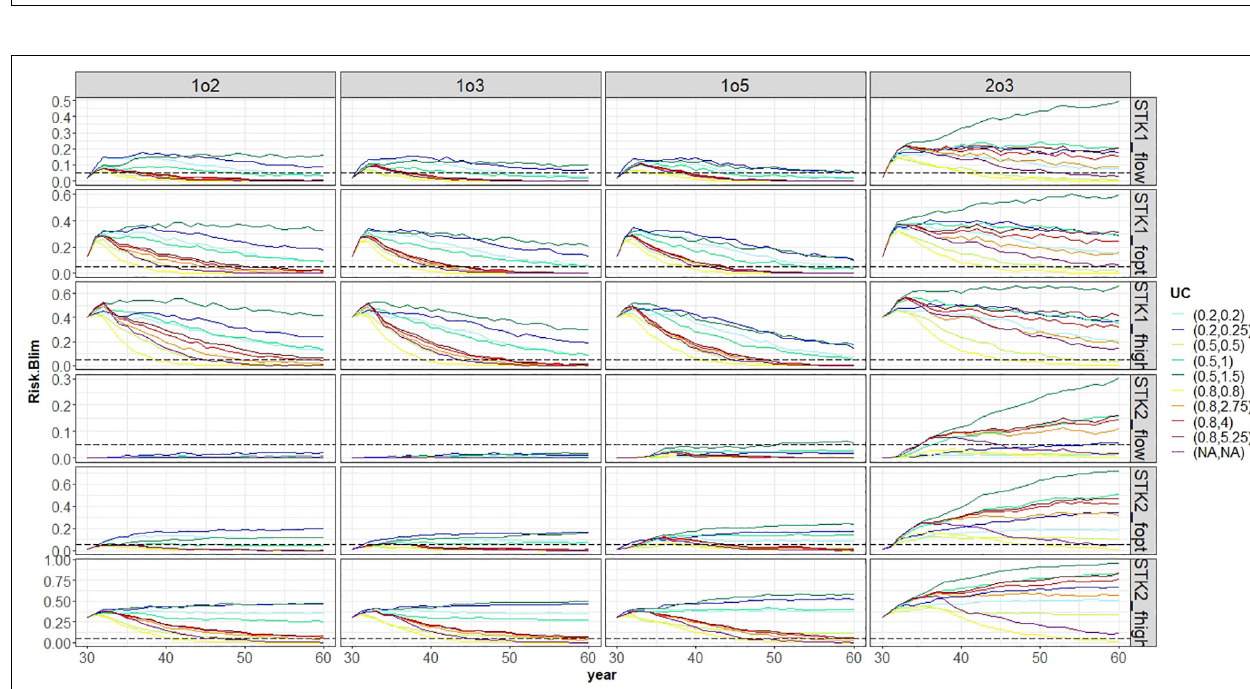
FIGURE 6 | Trajectories of biological risks (Risk3.Blim: maximum probability of falling below B lim ) along years (x-axis) under an in-year advice. The rows correspond to the operating models (combination of stock type and the historical exploitation level) and the columns to the harvest control rule type. The uncertainty cap lower and upper limits combinations are represented by different coloured lines. The horizontal dashed line corresponds to the 0.05 risk. See Table 1 for definitions of abbreviations. Interactive version of the figure is available online at https://aztigps.shinyapps.io/Sanchezetal2021_FMS/.